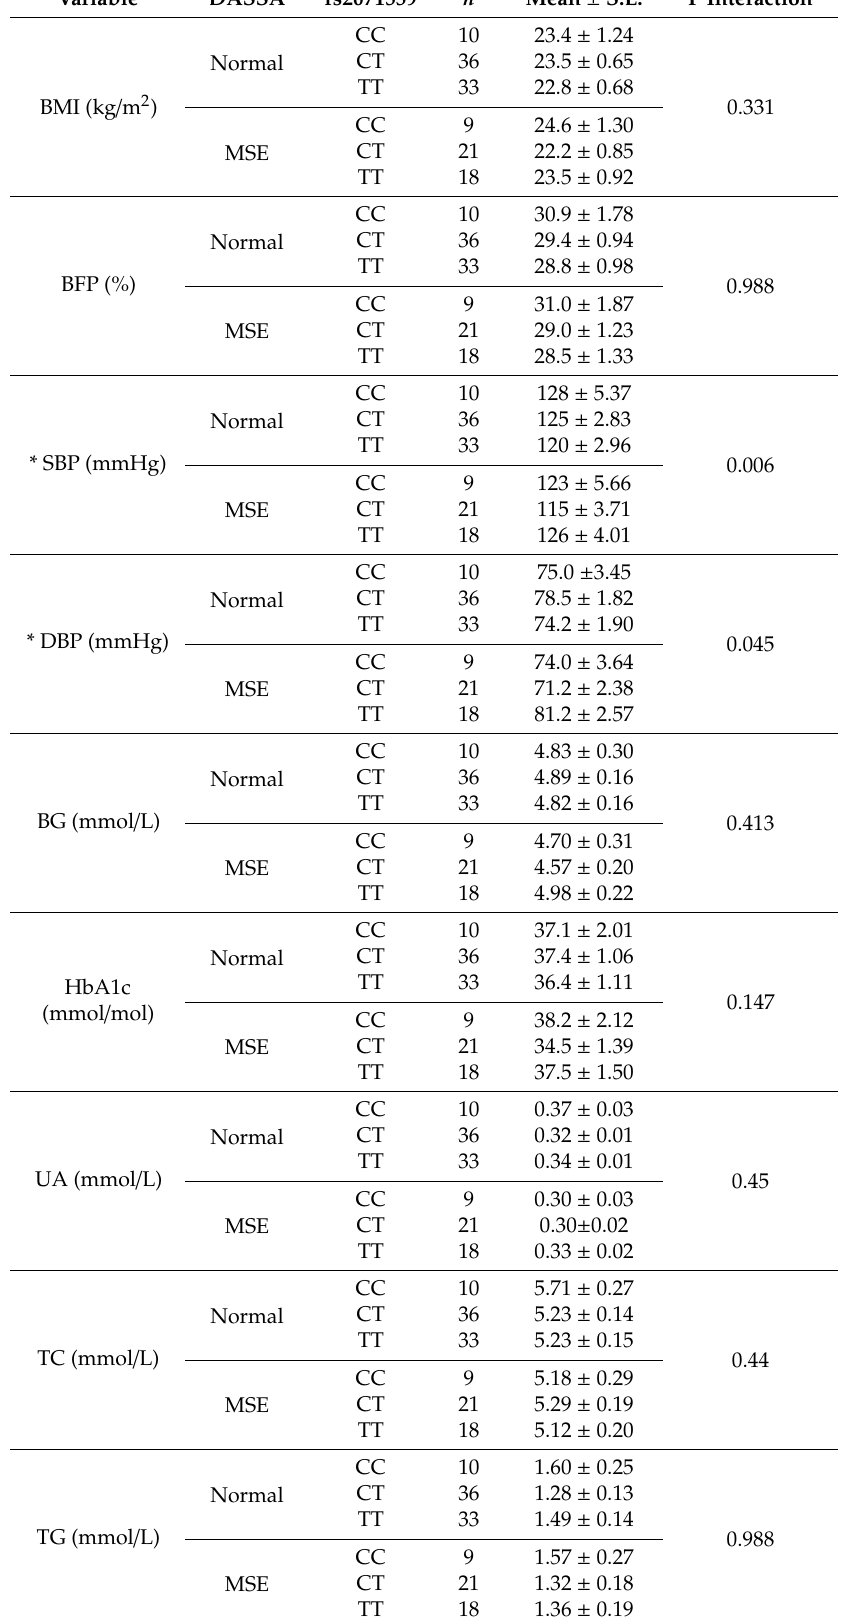
Table 5. Interaction between genotypes of VEGFR-2 gene rs2071559 SNP and categories of DASS for anxiety component on cardiometabolic risk